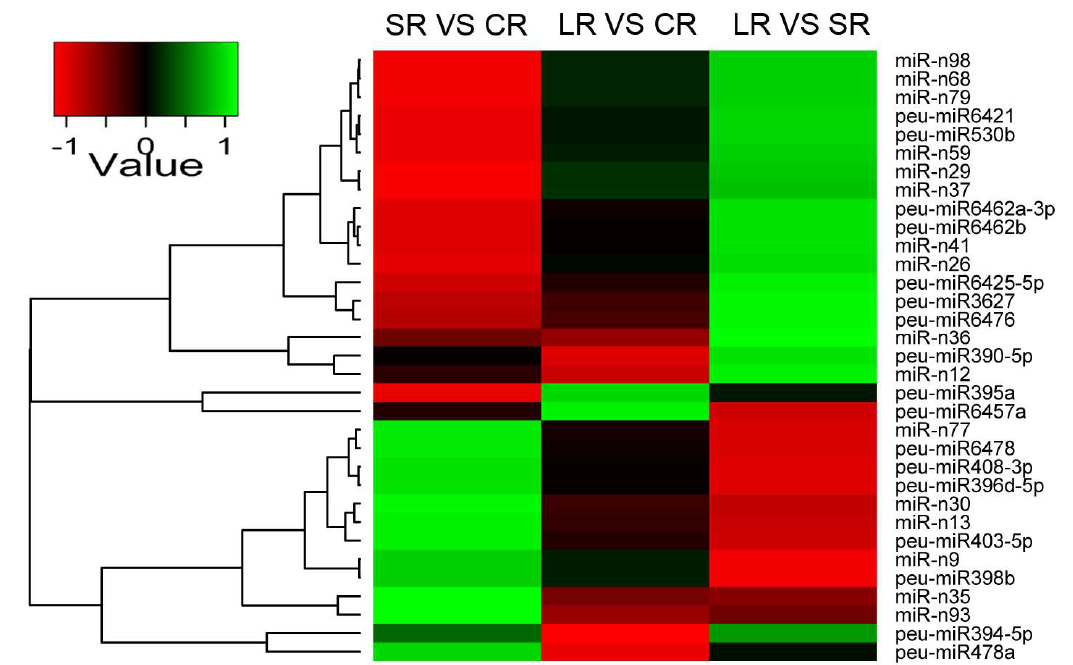
Figure 7. Hierarchical clustering analysis of differentially expressed miRNAs in response to ABA in the roots of P. euphratica . The expression profiles were analyzed by Genesis software (http://genome.tugraz.at/) with the hierarchical clustering method based on the TPM Log 2 FoldChange of miRNAs.